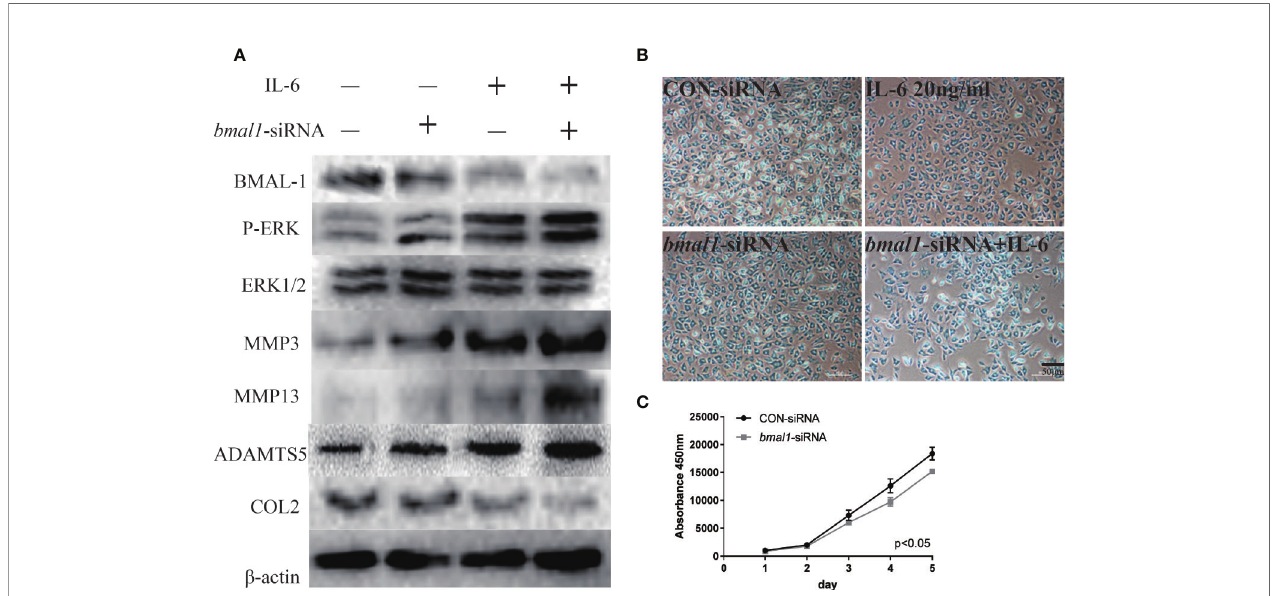
FIGURE 5 | BMAL-1 regulates TMJ-OA in vitro via the MAPK/ERK signaling pathway. (A) MCCs transiently transfected with control siRNA (con-siRNA) or bmal1 - siRNAs were cultured in the presence of IL-6. Western blots of MCC lysates showed increased P-ERK, MMP3, MMP9, and MMP13 levels and inhibited COL2 expression in cells transfected with bmal1 -siRNAs and treated with or without IL-6. (B) Alcian blue staining results for MCCs transfected with 50 nM con-siRNA or 50 nM bmal1 -siRNAs in normal medium or stimulated with 20 ng/ml IL-6 for 12 h. (C) BMAL-1 knockdown inhibited MCC proliferation in normal medium, as determined by CCK-8 assays. All experiments were performed in triplicate, and the results are expressed as the mean ± SD. The P value is written in the fi gure corner. Scale bar: 50 m m.